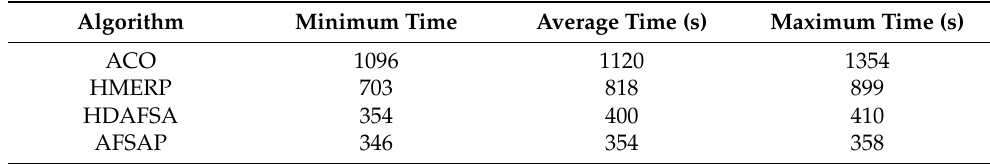
Table 2. Evacuation time of four